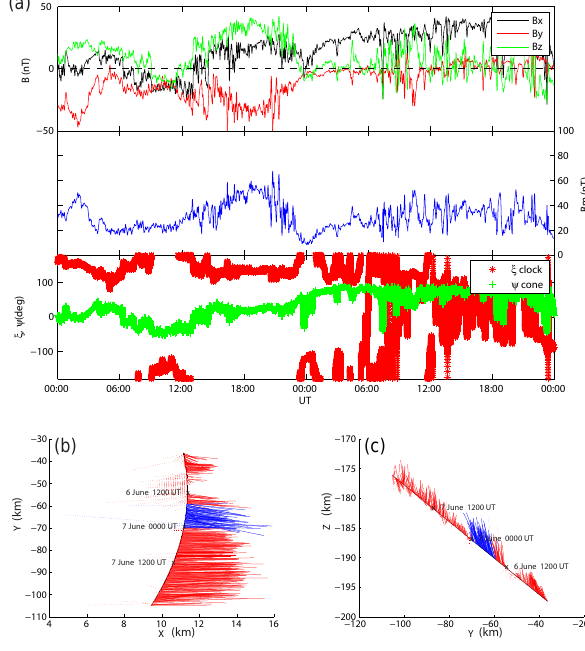
Figure 5. Panel (a) from top to bottom: the magnetic field com- ponents, the total magnetic field strength and the clock ξ and cone ψ angle of the magnetic field. Panel (b) : the magnetic field plot- ted along the spacecraft orbit, with 5min resolution, in the CSEQ X - Y plane. The blue region depicts the interval of compressed mag- netic field. The dotted lines show where B x < 0. Panel (c) : same as panel (b) but in the CSEQ Y - Z plane. The axes in panel (b) and panel (c) have different scales for better visibility.